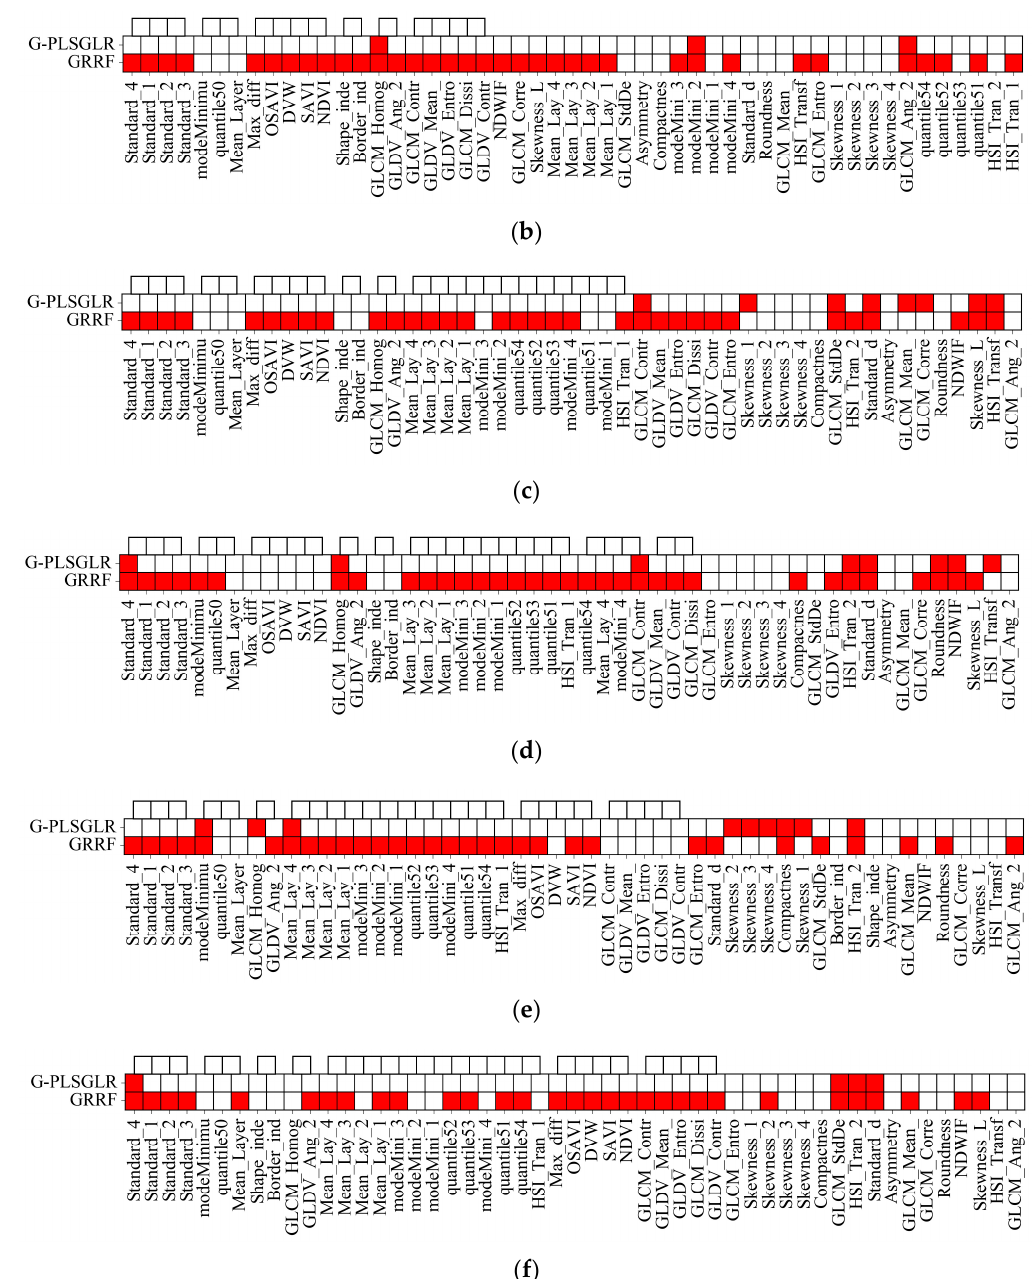
Figure 3. Tile map of the two methods, namely, G-PLSGLR and GRRF, against the selected features. The links on graphs are the feature grouping results from the G-PLSGLR. The selected features are depicted as red tiles across the x-axis. Water—selected features vs. methods ( a ); Forest land—selected features vs. methods ( b ); Grass land—selected features vs. methods ( c ); Crops land—selected features vs. methods ( d ); Bare land—selected features vs. methods ( e ); Residential and build-up land—selected features vs. methods ( f ).